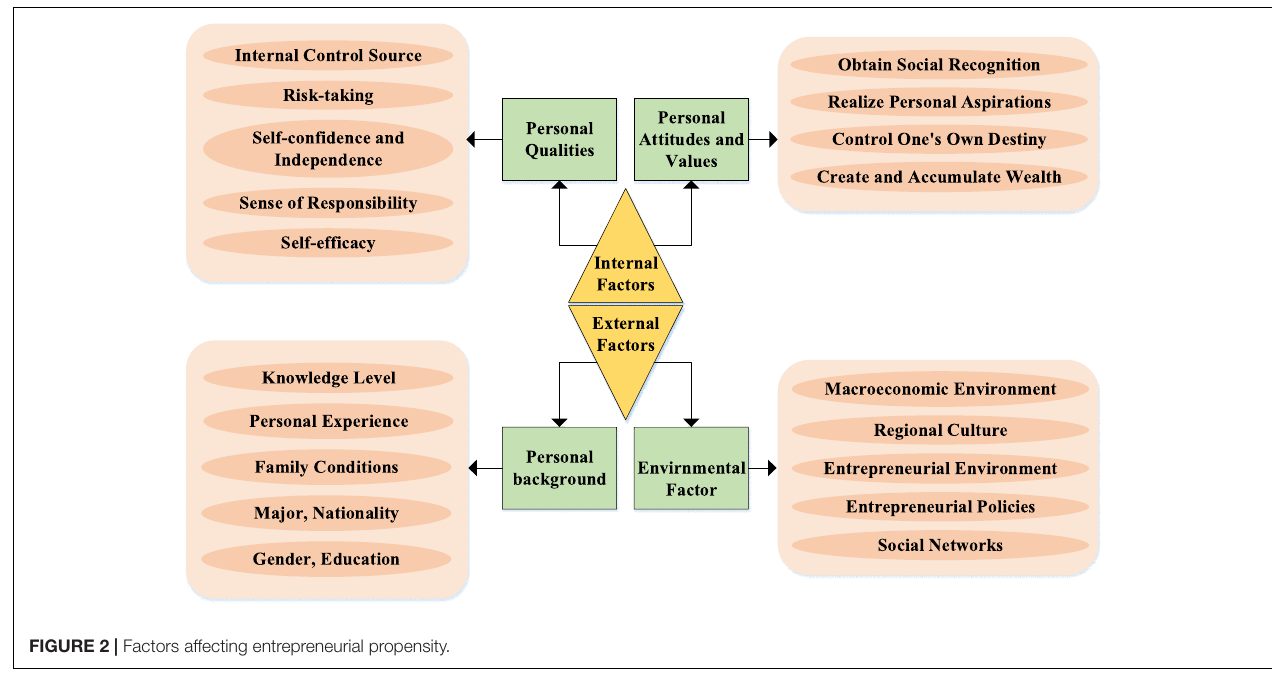
FIGURE 2 | Factors affecting entrepreneurial propensity.